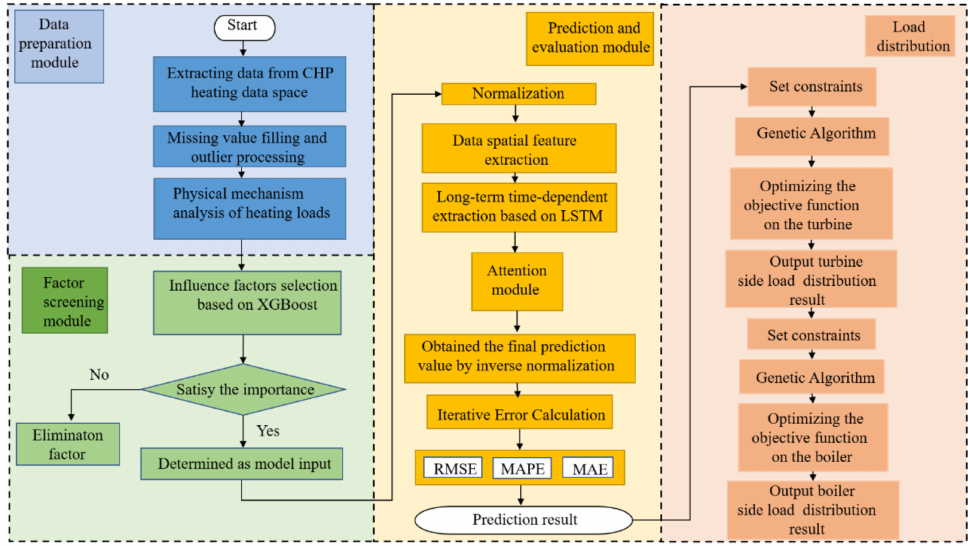
Figure 8. Research flow chart of this